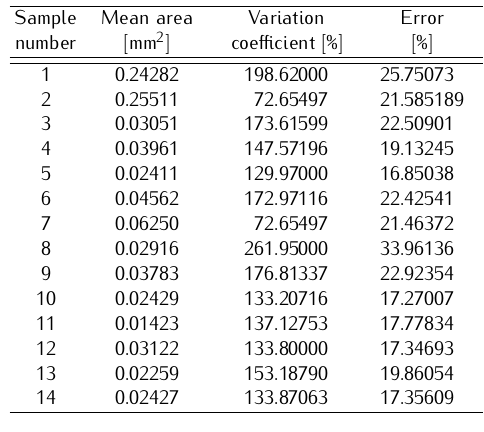
different structure (weave) and the higher warp and weft density of Sample 11, which is a precondition for a tighter fabric.